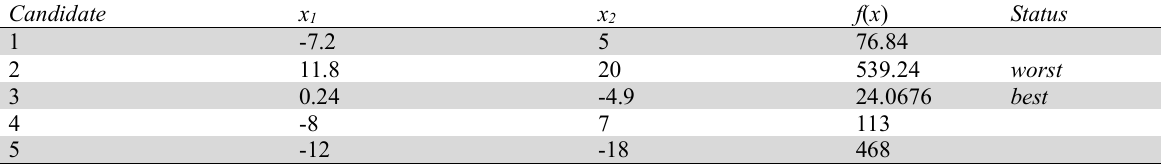
Updated values of the variables and the objective function based on fitness comparison at the end of second iteration (Rao-1) x